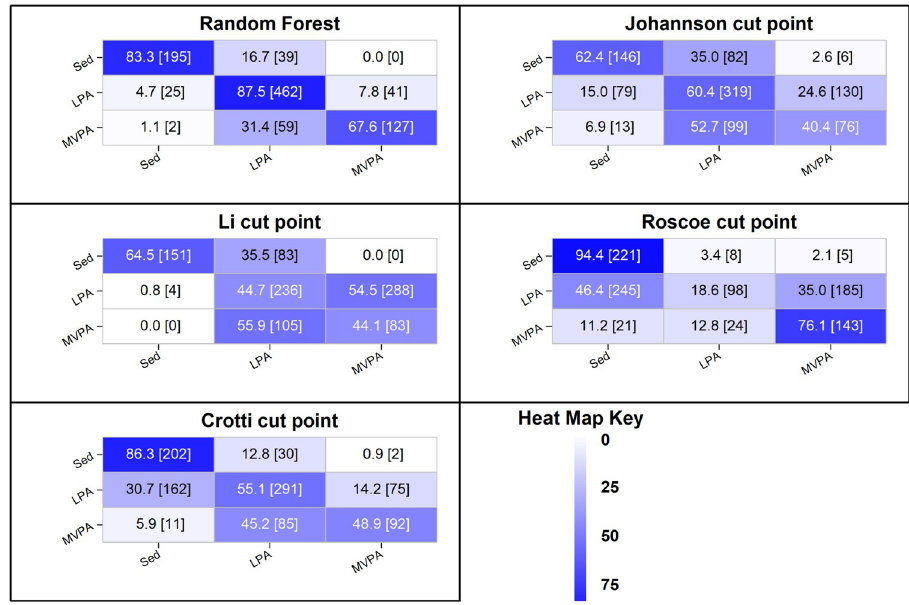
Fig 3. Heat map confusion matrix for the wrist placement free-living classifier cut-points. Diagonal = correct predictions; Columns = predictions; Rows = ground-truth.